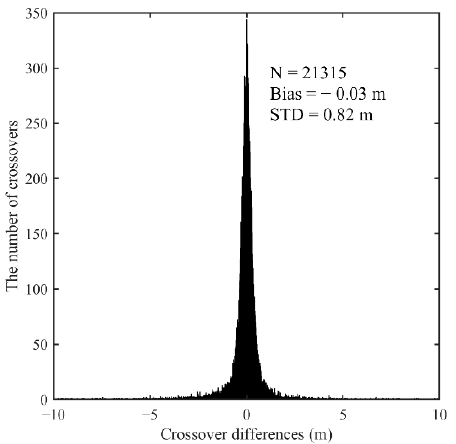
Figure 5. Histogram of crossover differences. The number of crossovers, the bias and standard deviation (STD) of crossover differences are shown.